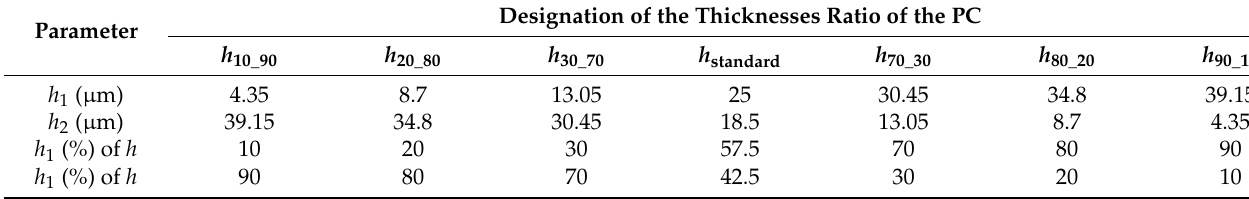
Table 1. Options for the ratio of internal and external PC.